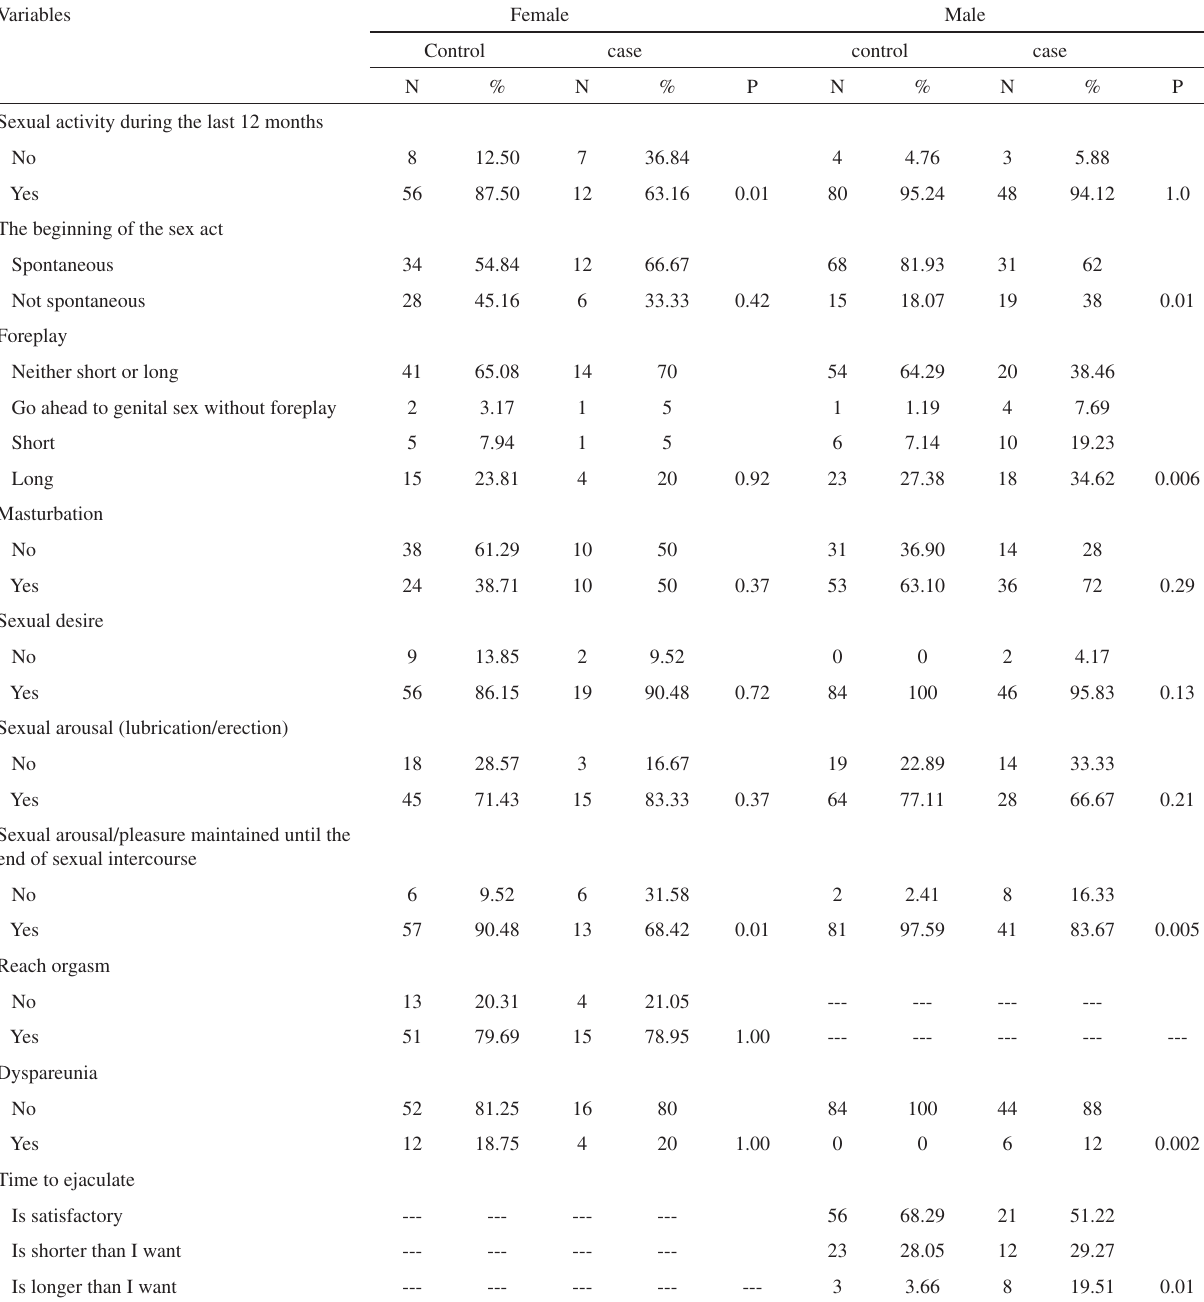
Table 2 - Frequency distribution of controls and cases according to sexual